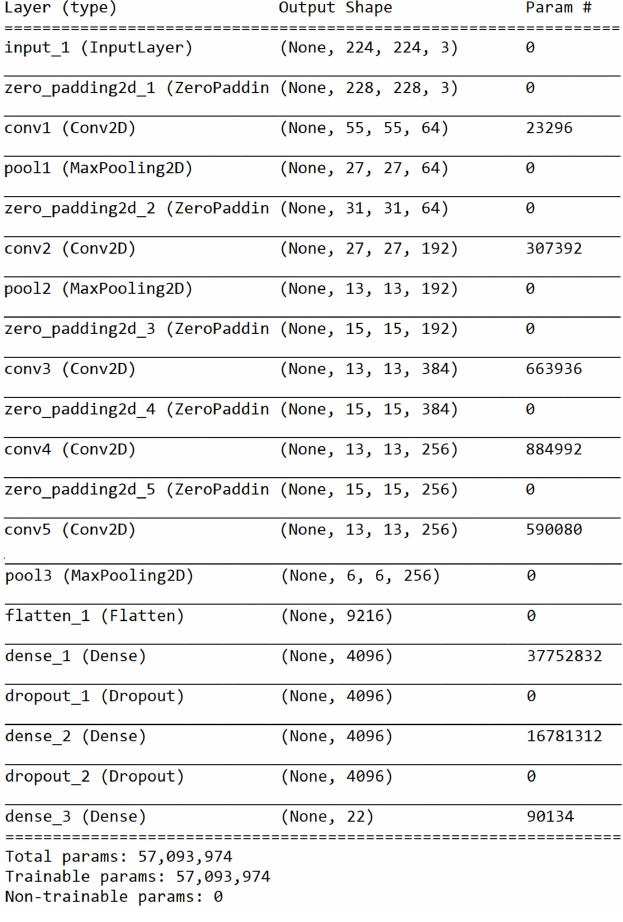
Figure 16. A summary of the AlexNet model in the first stage of the proposed method.